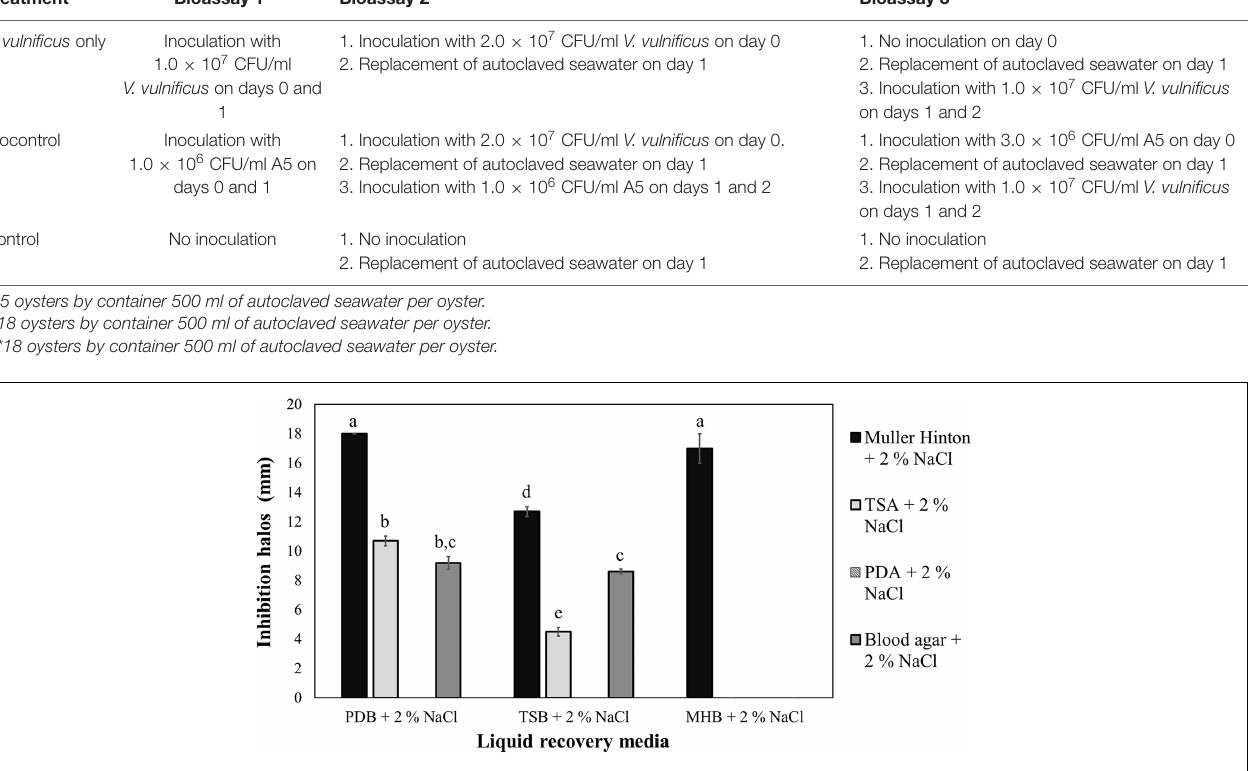
FIGURE 1 | In vitro sensitivity of Vibrio vulnificus to the strain A5 of Bacillus amyloliquefaciens (A5) recovered in three liquid media and assessed on four solid media. Equal letters indicate no significant differences ( p > 0.05). The absence of bars represents no observed inhibition halos.